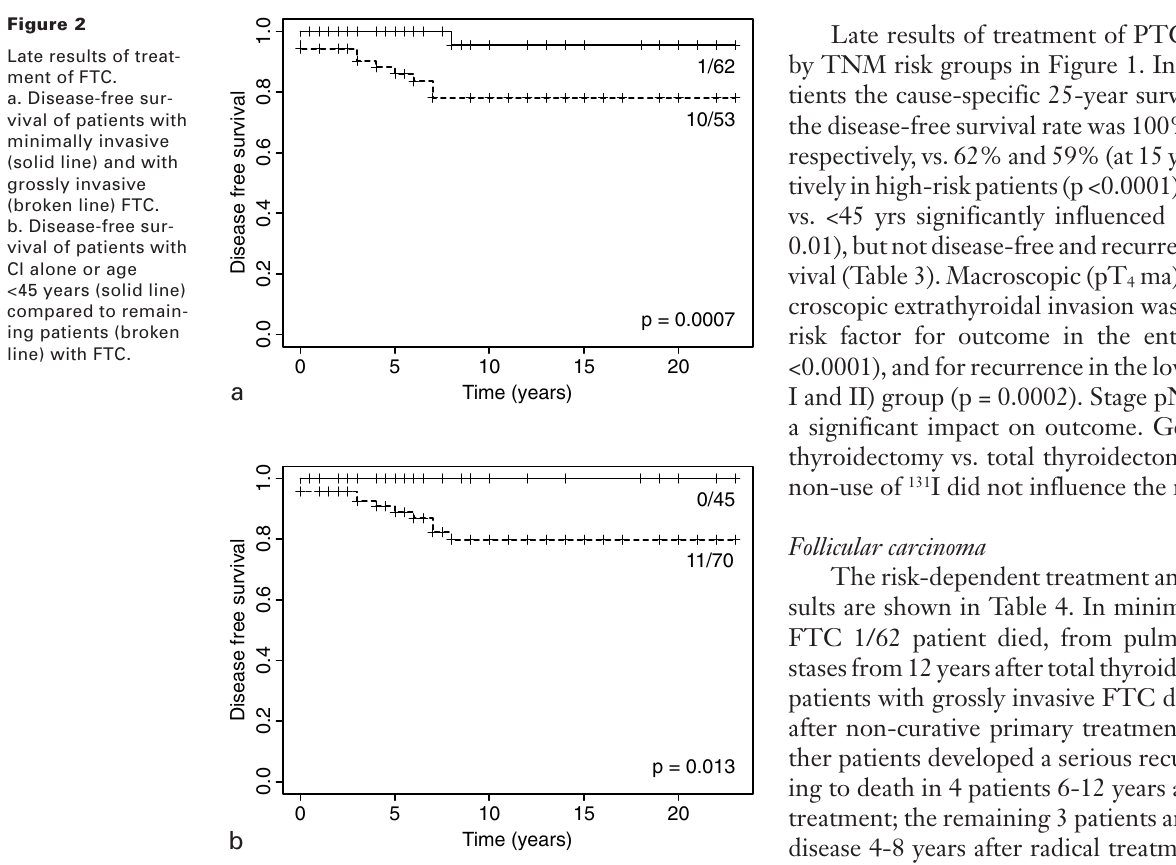
Late results of treatment of PTC are plotted by TNM risk groups in Figure 1. In low-risk pa- tients the cause-specific 25-year survival rate and the disease-free survival rate was 100% and 96.5% respectively, vs. 62% and 59% (at 15 years) respec- tively in high-risk patients (p <0.0001). Age ≥ 45 yrs vs. <45 yrs significantly influenced survival (p = 0.01), but not disease-free and recurrence-free sur- vival (Table 3). Macroscopic (pT croscopic extrathyroidal invasion was a significant